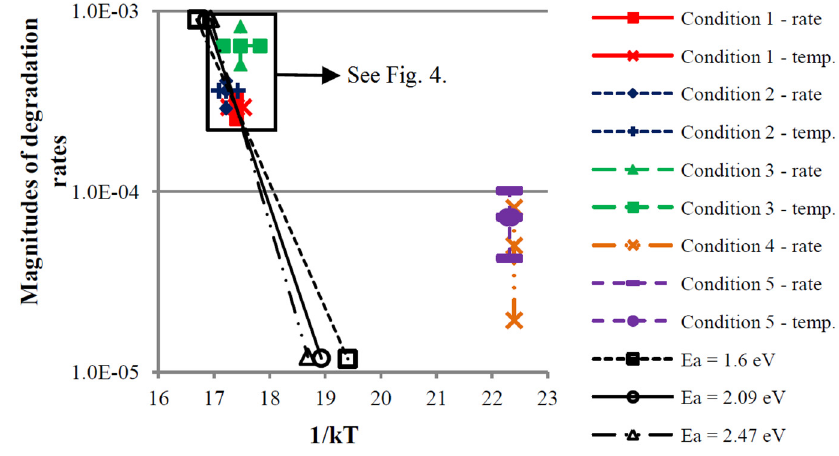
Figure 3. Comparison of Agilent power supply (San Jose, Ca, USA) measurement error and initial channel temperature ( T ch ) estimates in the 300-h test.